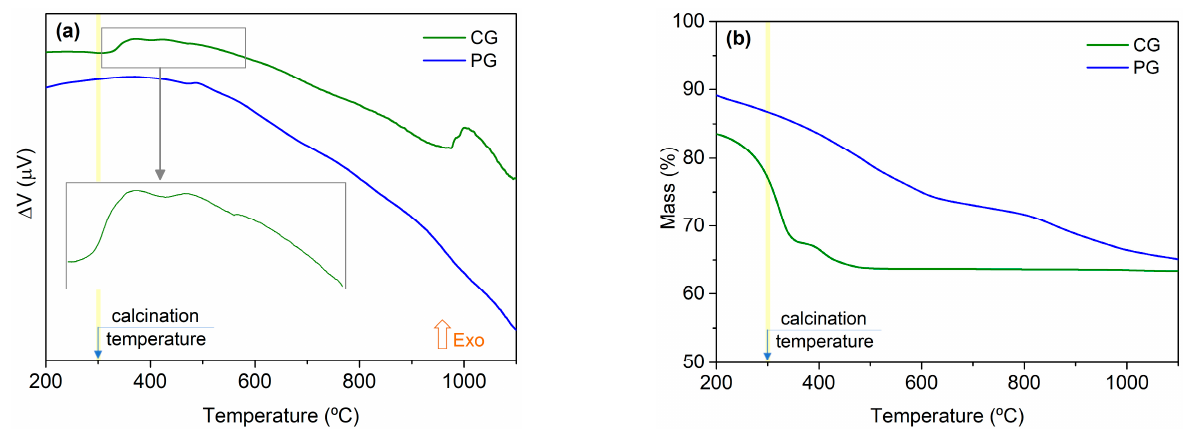
Figure 3. Flow chart for the ( a ) colloidal gel and ( b ) polymeric gel methods.